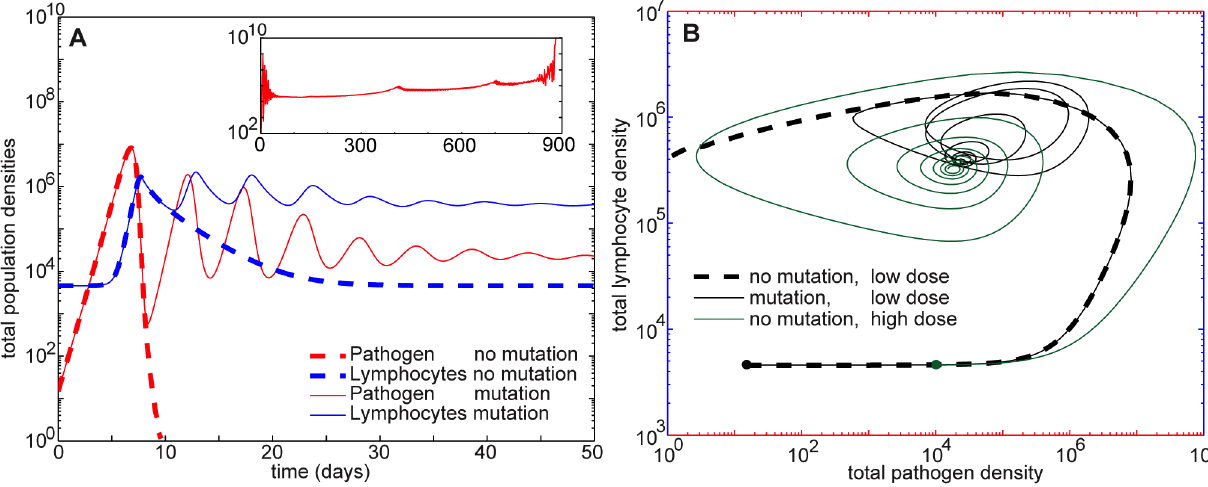
Figure 3. Coevolutionary dynamics in the first 50 days of infection. Shown here are the mutating infection from Fig. 1 and a non-mutating infection with the same parameter values. A. Plots of total pathogen and total T-cell populations for both non-mutating (dashed) and mutating infections (solid curves). When there is no mutation, the pathogen density decays below the threshold and is set to zero. With mutation, pathogens escape clearance as strains arise with lower affinity to the T-cell response (see Fig. 1A). Both pathogens and T-cells then converge to an approximate equilibrium state corresponding to a chronic infection. The inset shows total mutating pathogen density for the entire 900-day infection, which displays qualitative features observed in HIV and SIV [31]; peaks in the chronic phase correspond to branching events (see Fig. 1). B. Phase plot of total T-cell versus total pathogen densities for the first 50 days of the two simulated infections in A and a third infection with a higher initial dose of pathogens. Of the low-dose infections, only the mutating case escapes clearance, converging to a chronic state similar to the approximate steady state (Eq. 12) existing in the non-mutating system. Parameters are given in Table 1.